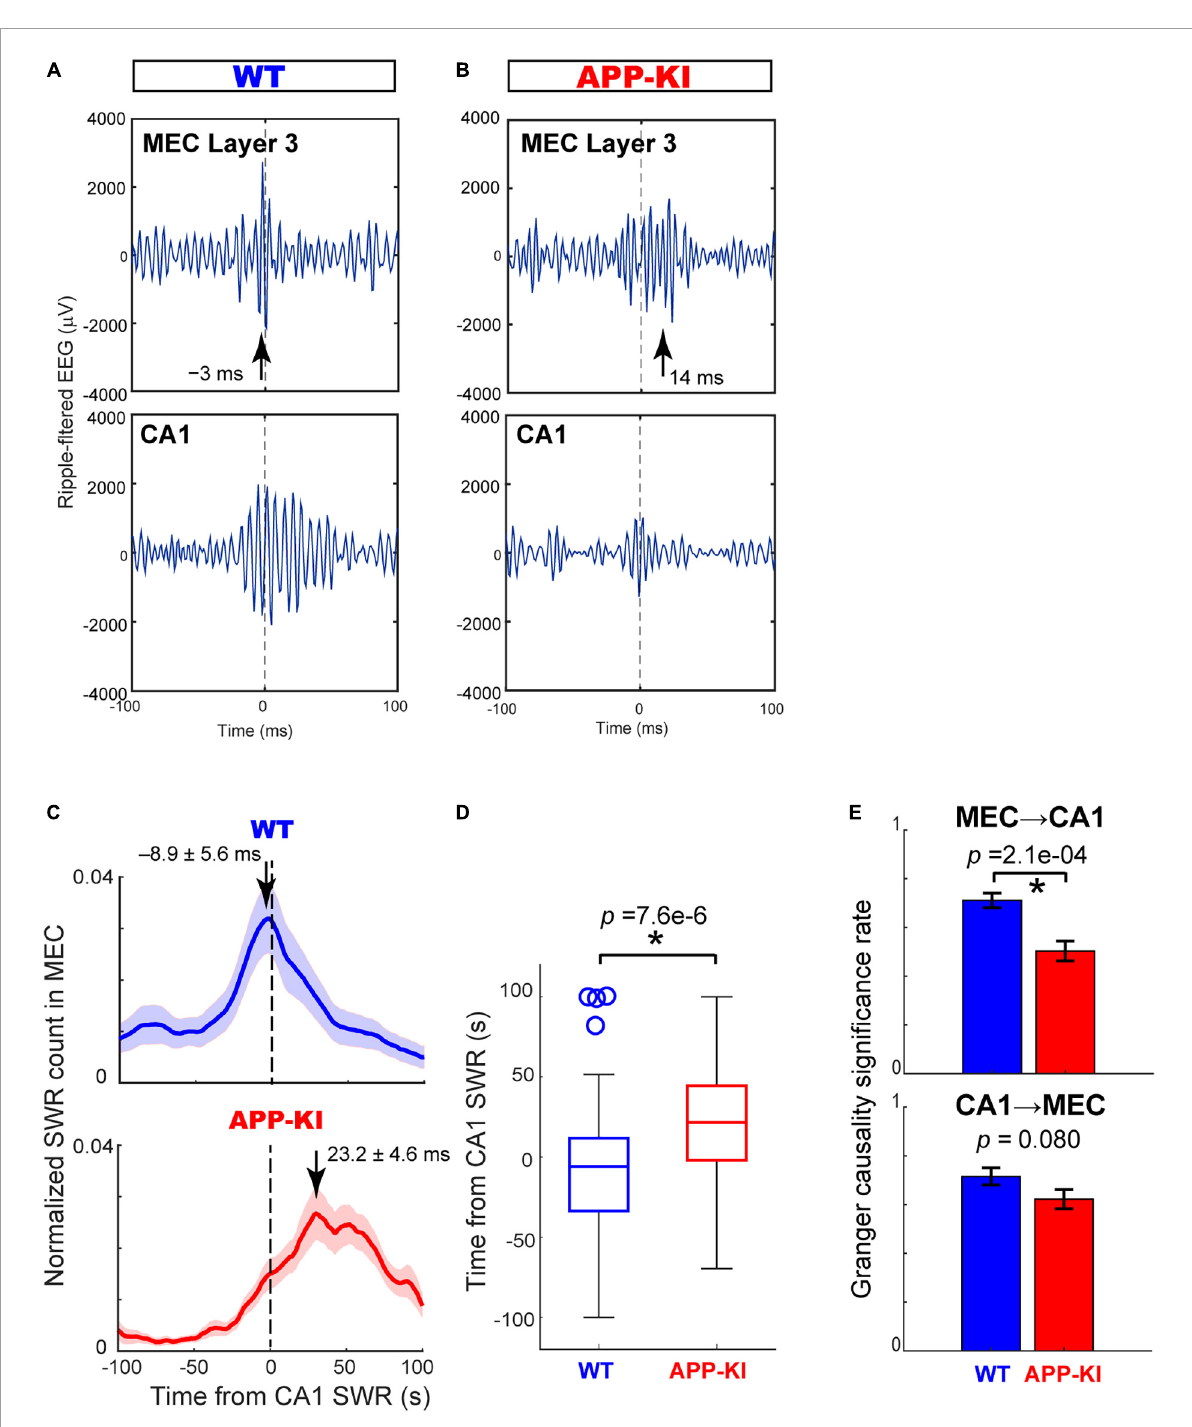
FIGURE5 Cross-correlogram and Granger causality revealed impaired SWR coordination between MEC and CA1. (A,B) Example SWR traces occurring simultaneously in the MEC and CA1 in WT (A) and APP-KI mice (B) . SWRs are aligned at the amplitude peaks of SWRs in CA1. Arrows depict peak times of SWRs in the MEC. (C) Normalized counts of SWRs in the MEC triggered by SWRs in CA1 for WT mice ( n = 65 electrode pairs) and APP-KI mice ( n = 61 electrode pairs). (D) Peak time of MEC SWRs relative to SWRs occurring in CA1. p = 7.6 × 10 6 , Wilcoxon rank-sum test. (E) Significance rate obtained from Granger causality test on SWRs from MEC to CA1 (top, p = 2.1 × 10 4 , Wilcoxon rank-sum test) and from CA1 to MEC (bottom, p = 0.080, Wilcoxon rank-sum test). * p <